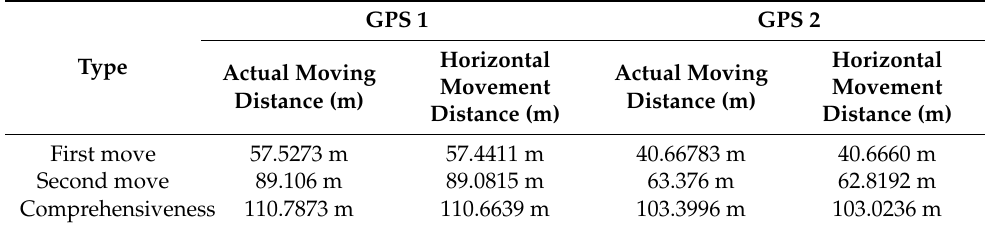
Table 2. GPS equipment monitors displacement changes.